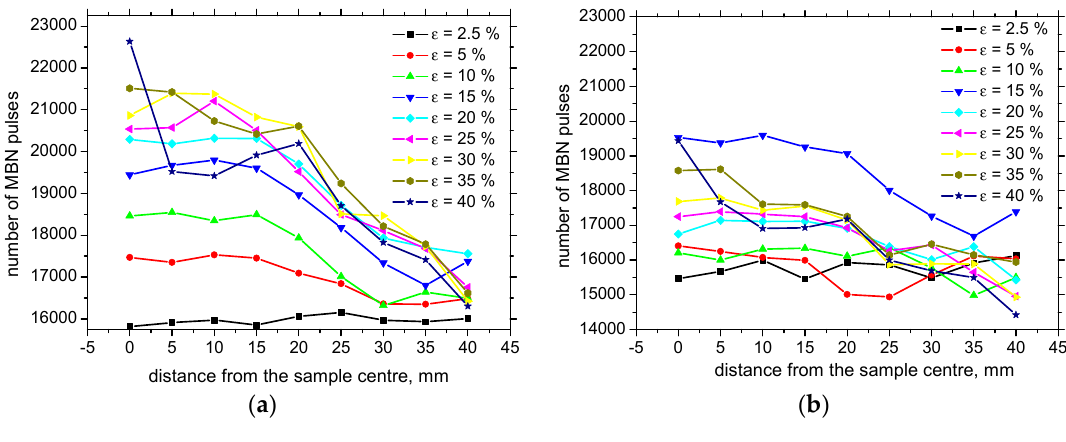
Figure 17. Number of MBN pulses versus ε . ( a ) RD; ( b ) TD.